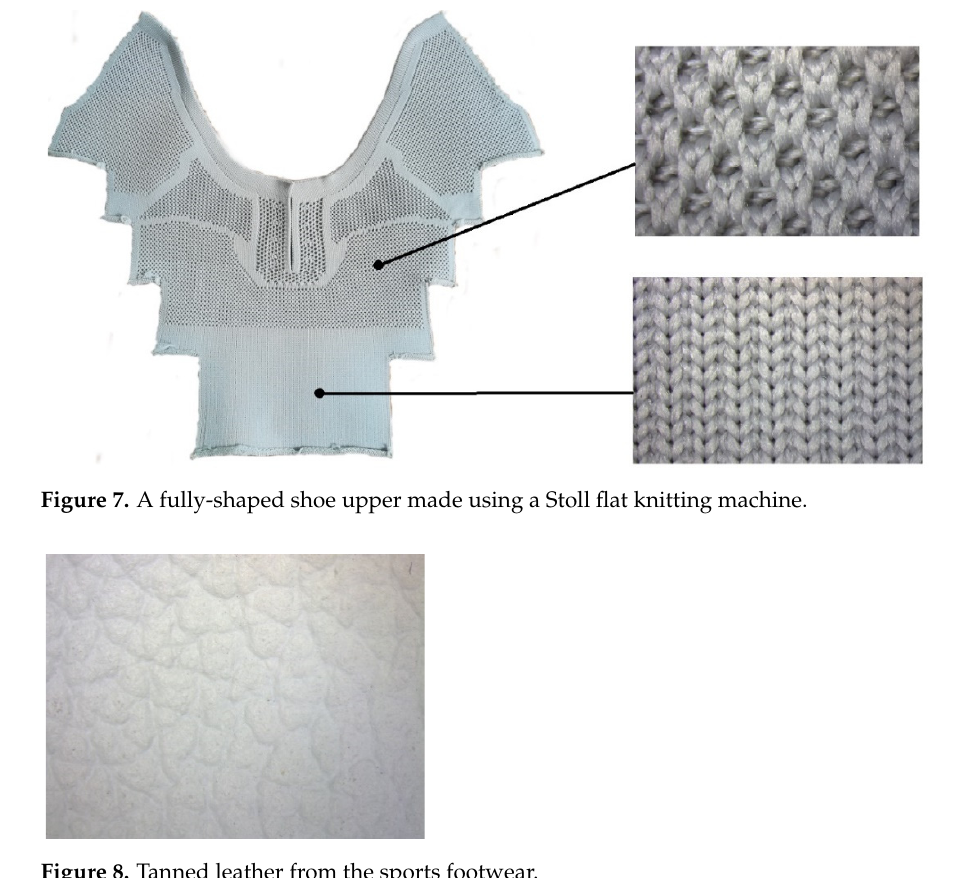
Table 3. A summary of the tensile strength tests conducted according to the EN ISO 13934-1:2002 standard.